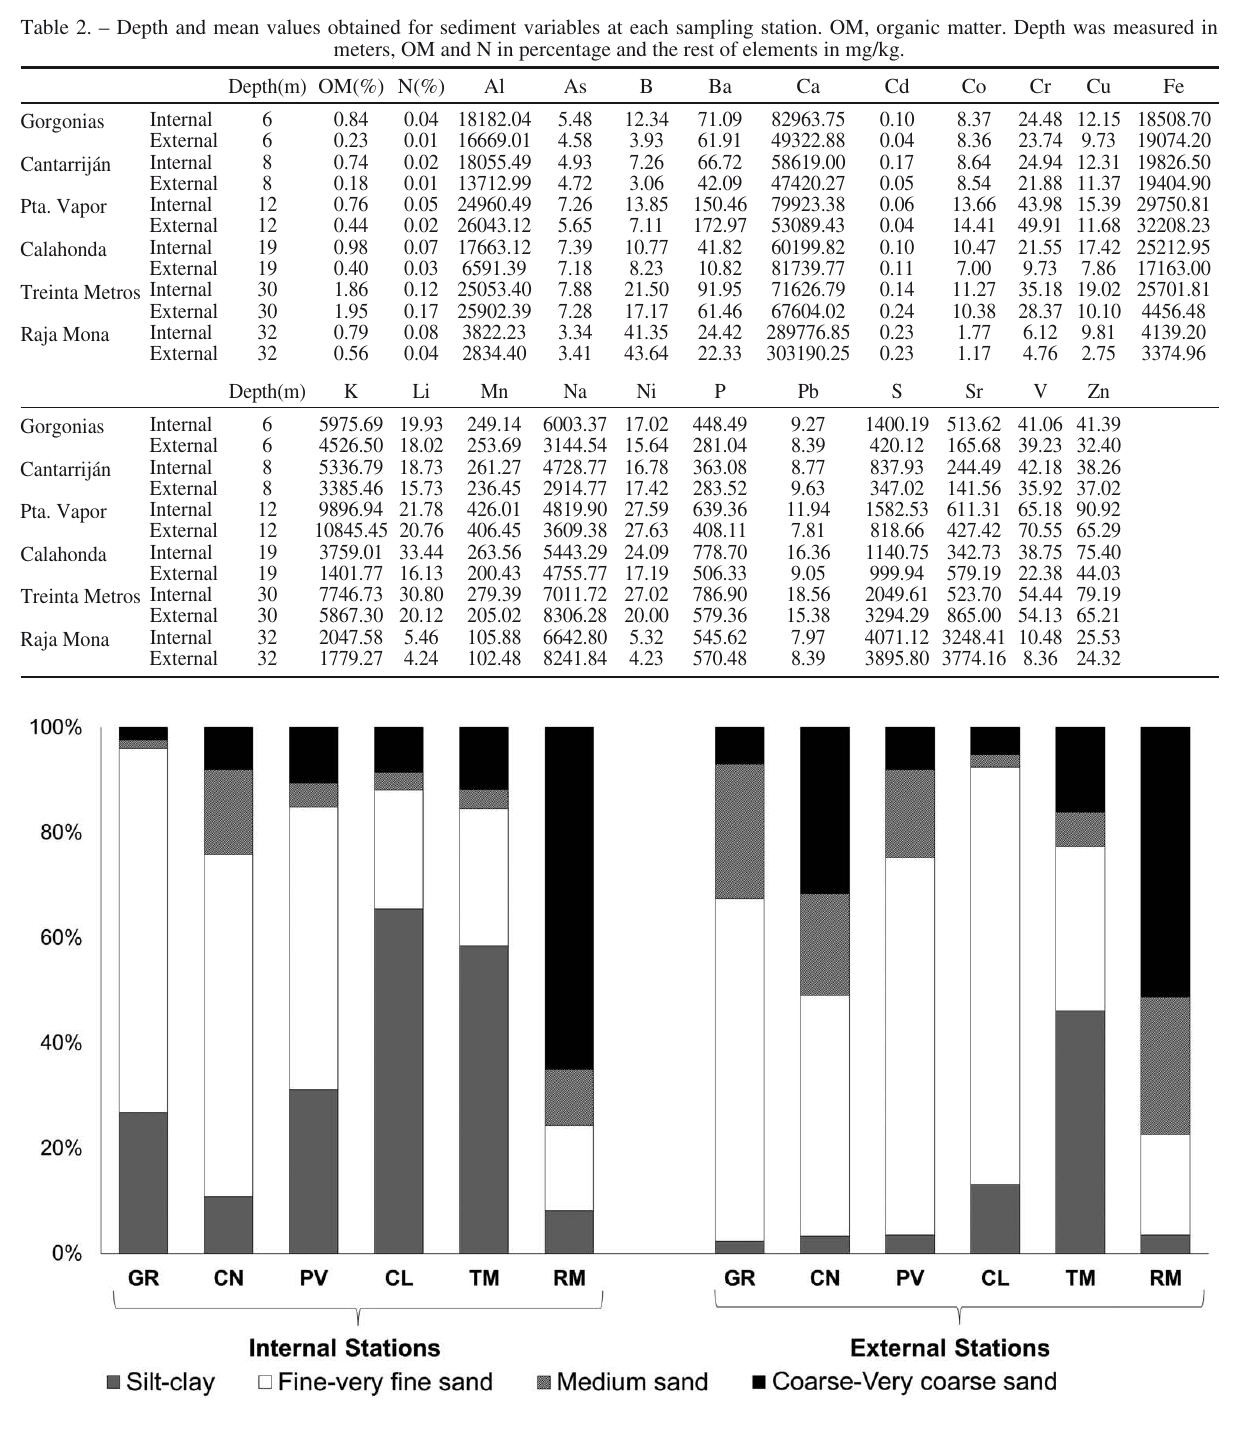
Fig. 3. – Percentage of the different granulometric fractions at each sampling